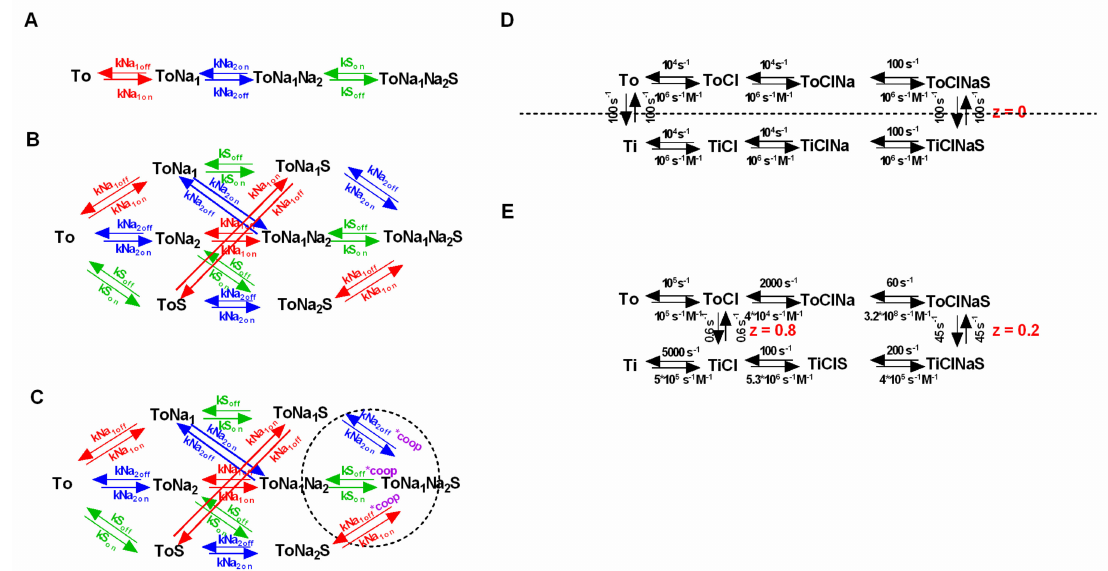
Figure 5. Random order binding of co-substrate and substrate and incorporation of cooperativity. ( A ) and ( B ) Sequential and the corresponding random order binding scheme, respectively. Both schemes adhere to a stoichiometry of Na + :S = 2:1. Rates are shown in the same color (i.e., blue, green or red) if they parameterize the binding of the same ligand. ( C ) Cooperative binding scheme. To implement cooperativity a coop factor (coop in magenta) was introduced in the highlighted loops (dashed circle). The coop factor is a number between 0 and 1, which when multiplied with the indicated dissociation rates, renders the model cooperative. ( D ) Example of a symmetric model. Intra—and extracellular—co-substrate and substrate a ffi nities are the same, and the inward- and the outward-facing states are equally stable. The dashed line indicates the axis of symmetry. ( E ) Asymmetric Model of dopamine (DAT) [22]. Shown in the scheme are the published rates and